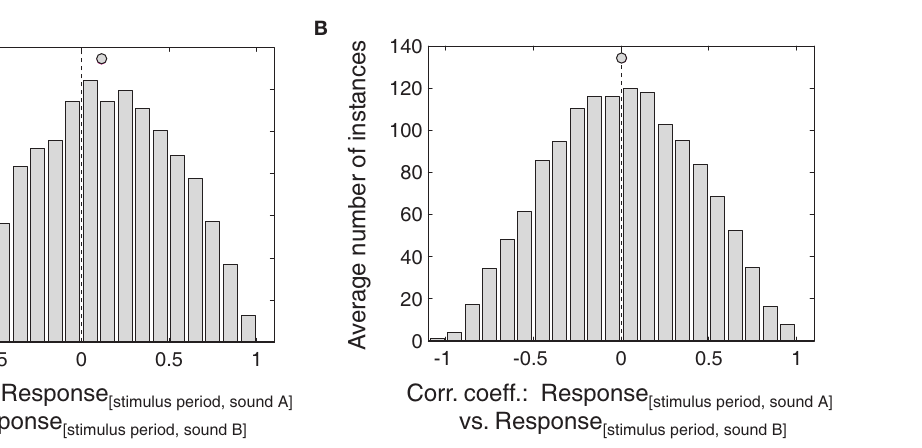
the correlation of stimulus period responses for sound A versus sound B (A) and for sound A minus sound B versus sound B ( B ) for eye position-sensitive IC neurons. Each neuron-sound location combination was treated as a separate case. Filled circles indicate the